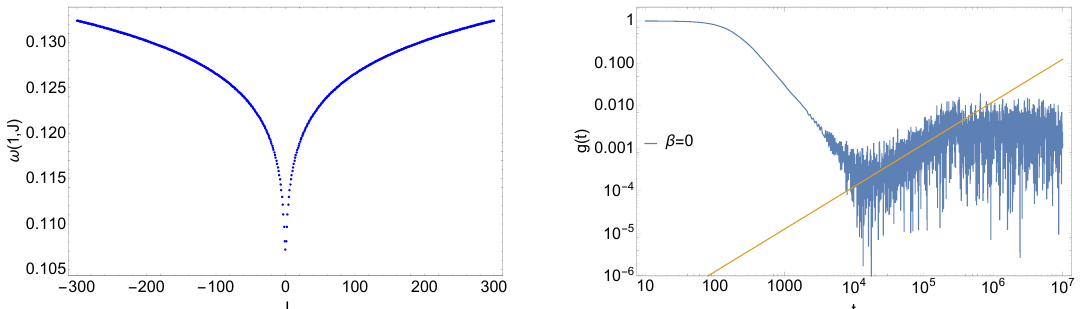
Figure 1. Plot of energy levels ω (1 , J ) (left) and the β = 0 spectral form factor (right) for BTZ black hole normal modes with z = 30 , n = 1 and J = 300 . The notations are defined in later 0 cut sections, but the general message should be